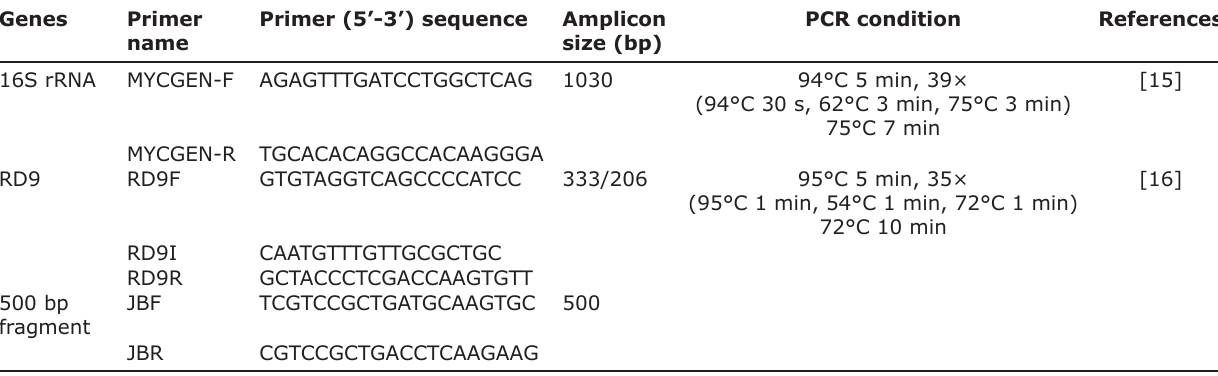
Table-1: Details of primers and thermal cycling condition for identification of Mycobacterium species and Mycobacterium tuberculosis complex.